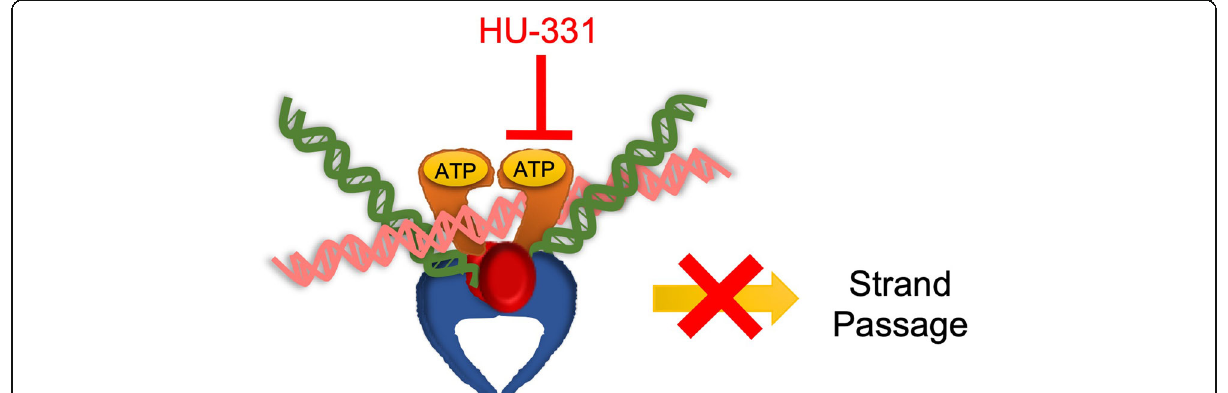
Fig. 2 HU-331 inhibits the catalytic cycle of topoisomerase II. TOP2 (orange, red, and blue) binds to two segments of DNA (pink and green). HU- 331 blocks ATP hydrolysis by the ATPase domain (orange), which results in the inability to perform strand passage and traps the enzyme on